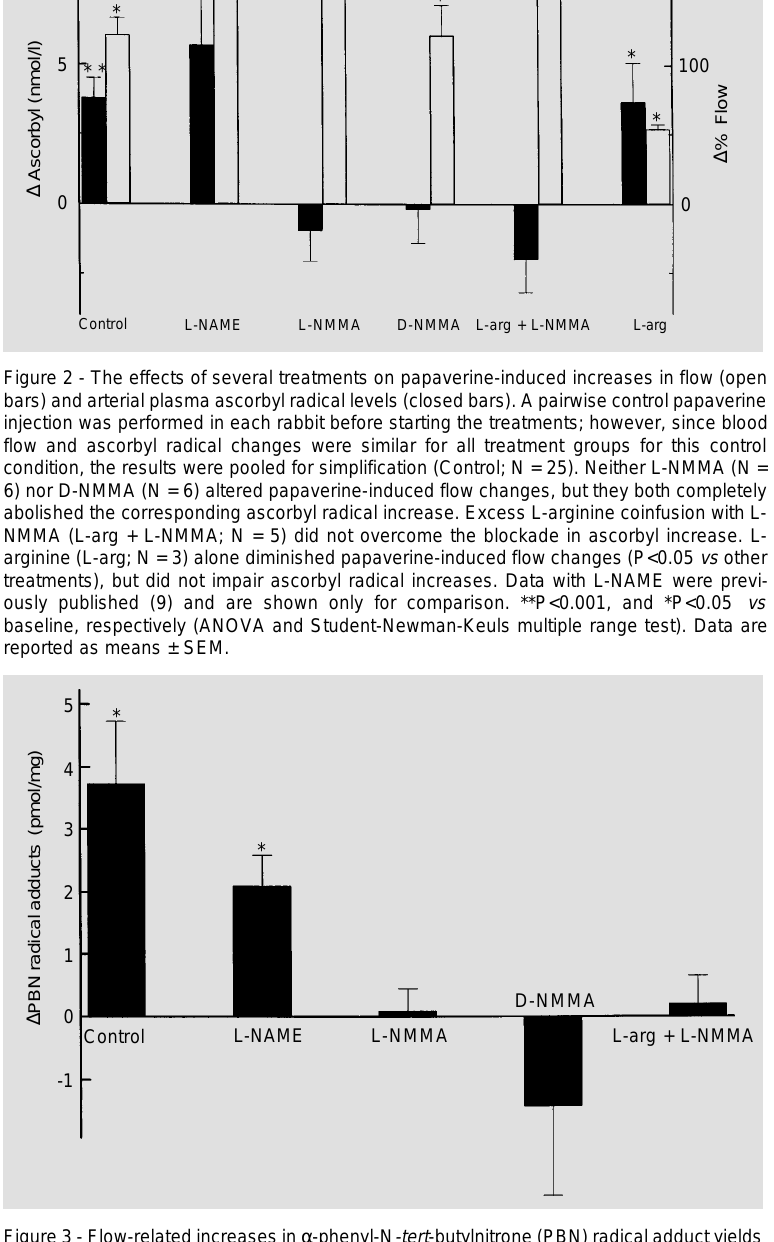
Figure 3 - Flow-related increases in a -phenyl-N-tert-butylnitrone (PBN) radical adduct yields in endothelialized aortas in the control (Control) condition and after treatment with L-NMMA (N = 4), D-NMMA (N = 4) and L-arginine + L-NMMA (N = 3). Data with L-NAME (N = 5) were previously published (9) and are shown only for comparison. Both L-NMMA and D-NMMA completely blocked radical generation. L-arginine did not reverse the blockade. *P<0.02 vs baseline. The SNK multiple range test showed that the control group was different from all groups, except for L-NAME. The D-NMMA group did not differ from the L-NMMA or L-arg + L-NMMA group. Data are reported as means ±